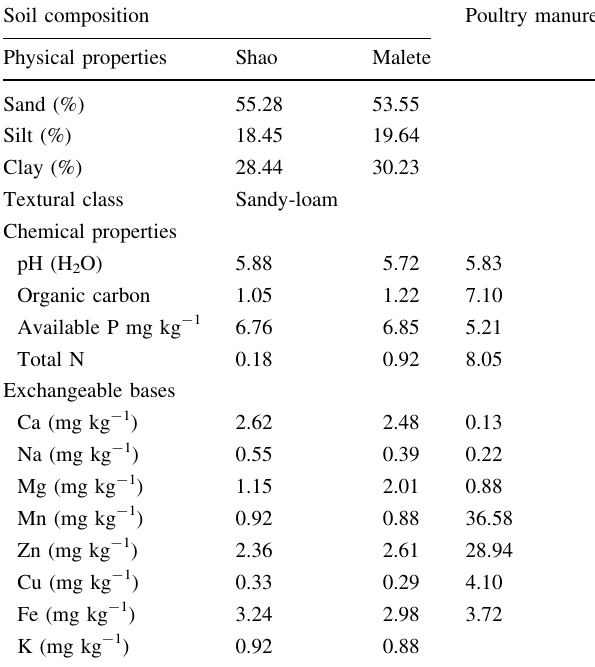
Table 2 Physio-chemical properties of the experimental